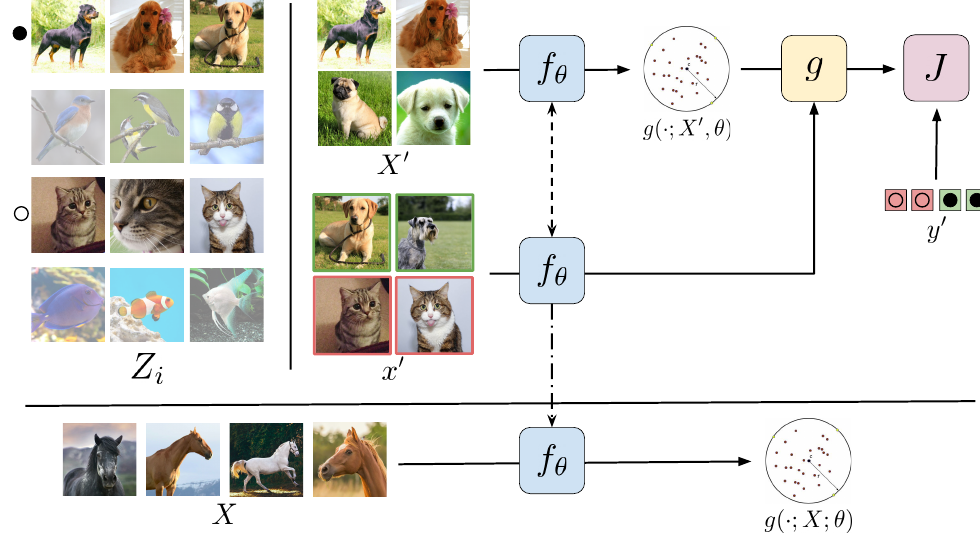
Figure 1. Overview of the proposed method. During the meta-training stage, we emulate a training stage by first sampling X (cid:48) from a distribution that is similar to the one of our target class data X . In practice we use all examples from class i —represented as the Z i sets in the figure—from a labeled dataset Z . We then sample a minibatch of pairs ( x (cid:48) , y (cid:48) ) with x (cid:48) being an example and y (cid:48) a binary label indicating whether x (cid:48) belongs to the same class as the examples in X (cid:48) , sampling again from sets Z i . Then, we use a one-class classification algorithm (e.g., SVDD) in the features resulting from applying f θ on the examples of X (cid:48) . We use the resulting classifier to classify each example’s features f θ ( x (cid:48) ) as belonging or not to the same class as X (cid:48) , and compute the binary loss J with the true labels y (cid:48) . We optimize f θ by doing gradient descent in the value of J over many such tasks. After f θ is learned, we run the same one-class classification algorithm on the resulting features, represented by the dashed-dotted arrow from the meta-training to the deployment stage, for X in the true training stage, yielding the final one-class classification